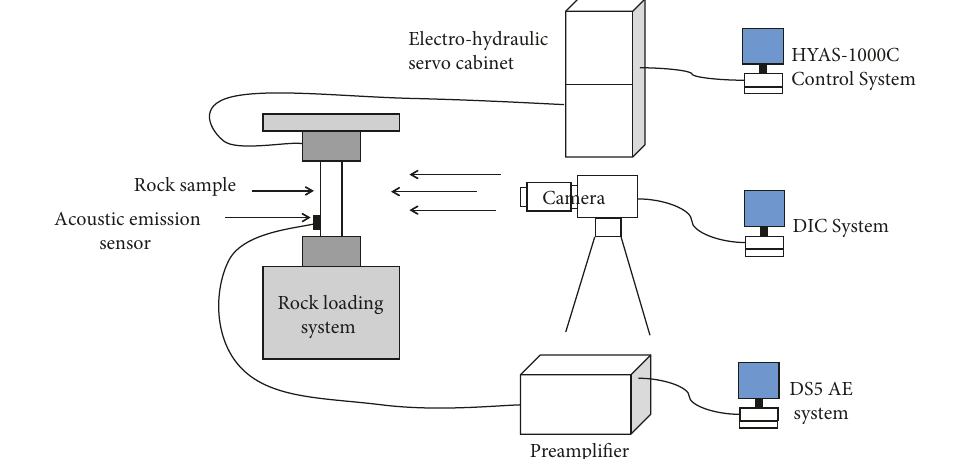
Figure 3: Test equipment.